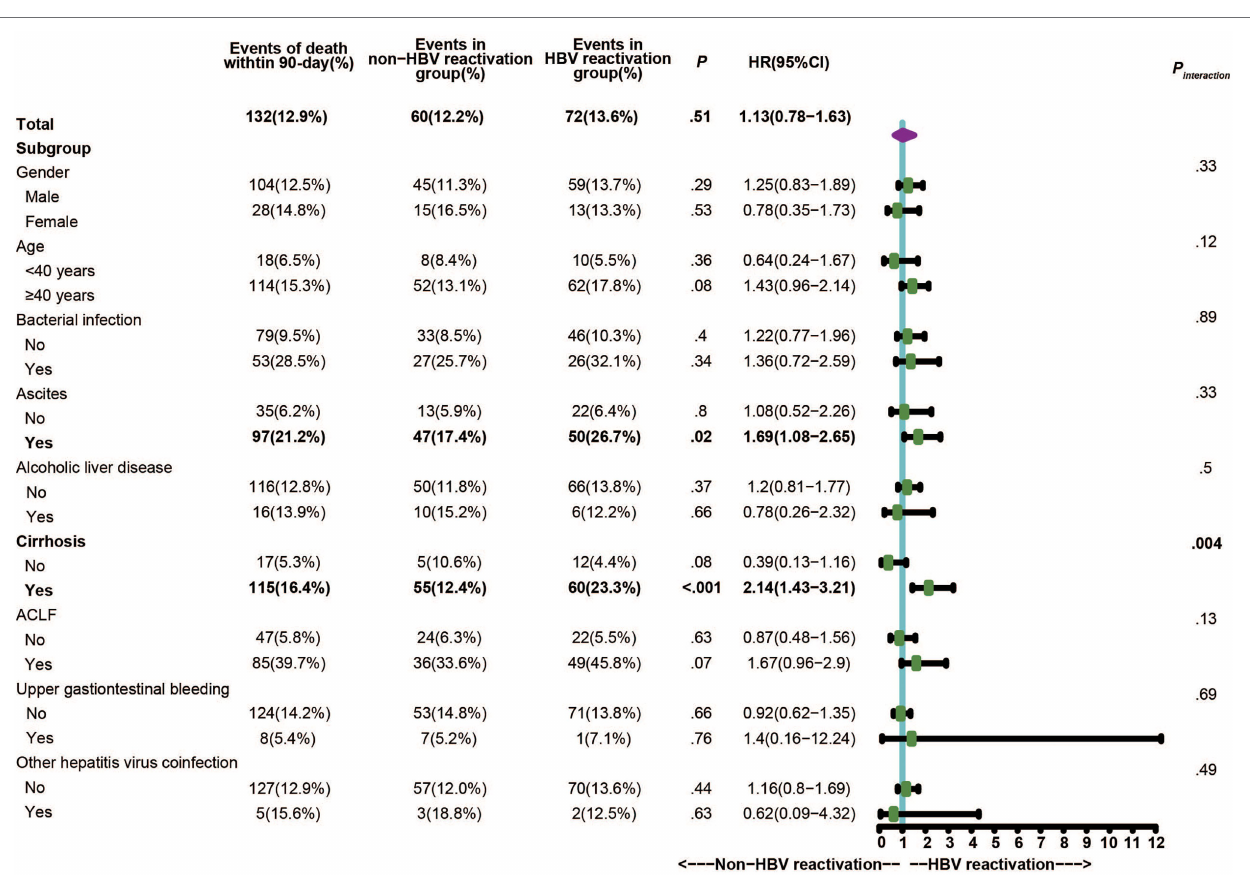
Table 2 . HBV reactivation [odds ratio (OR) = 2.01, 95% CI = 1.40–